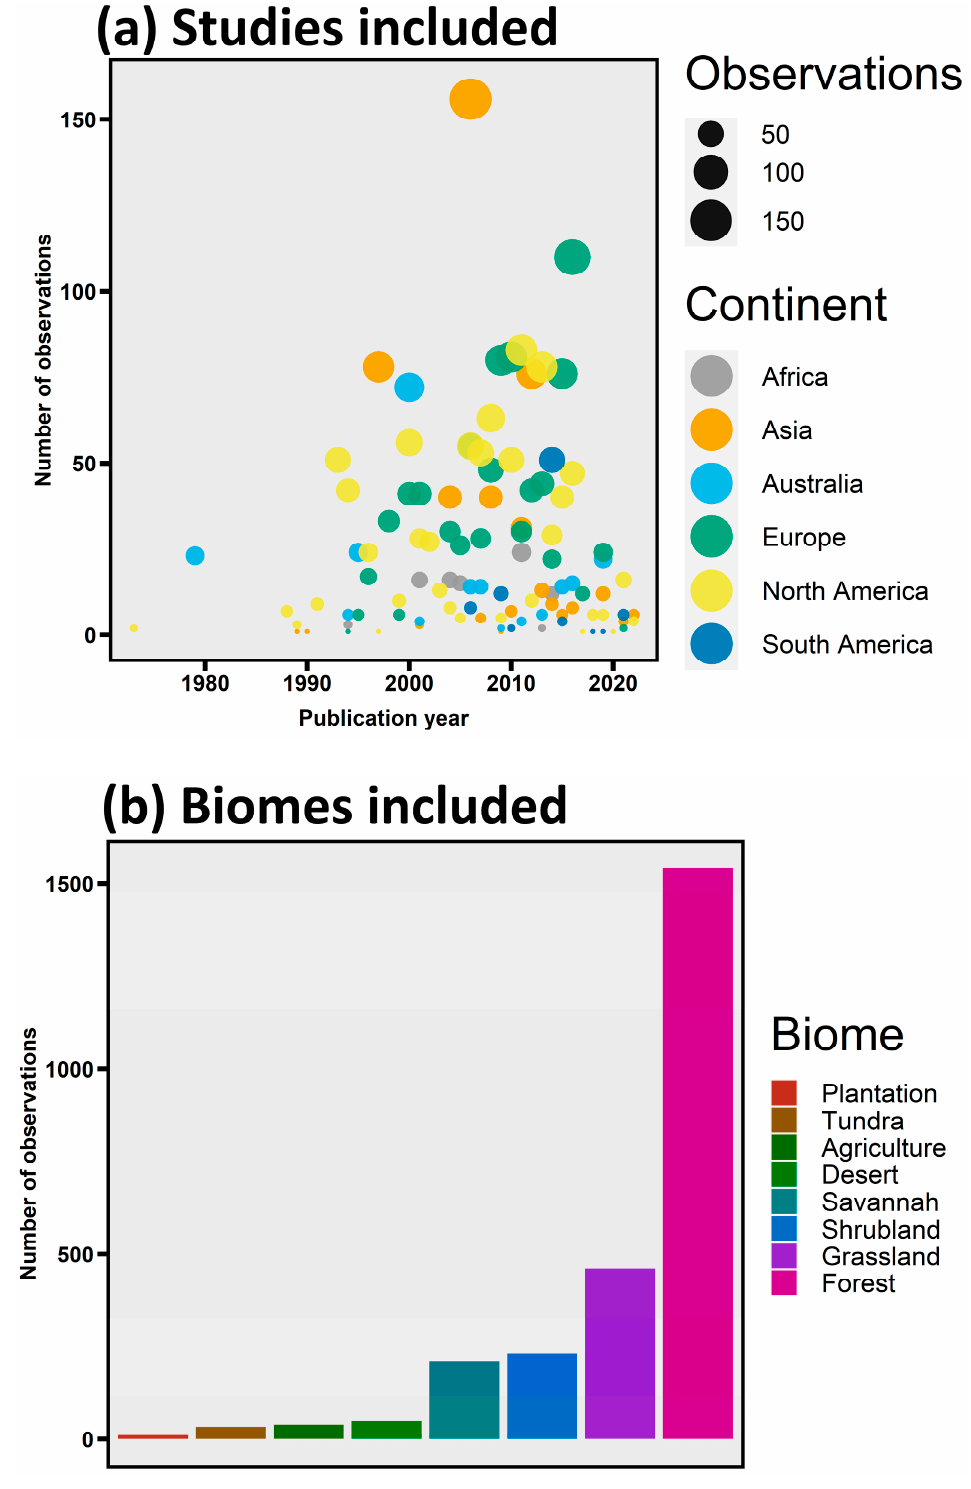
Figure 1. The locations of study sites (N = 208) that met all selection criteria and were used for meta-analysis. Classification of biomes is based on Olson et al. [94].